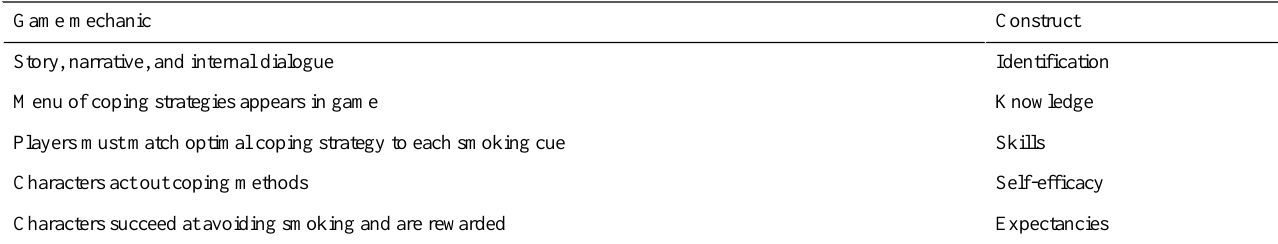
Table 1. Game mechanics and related behavioral constructs.